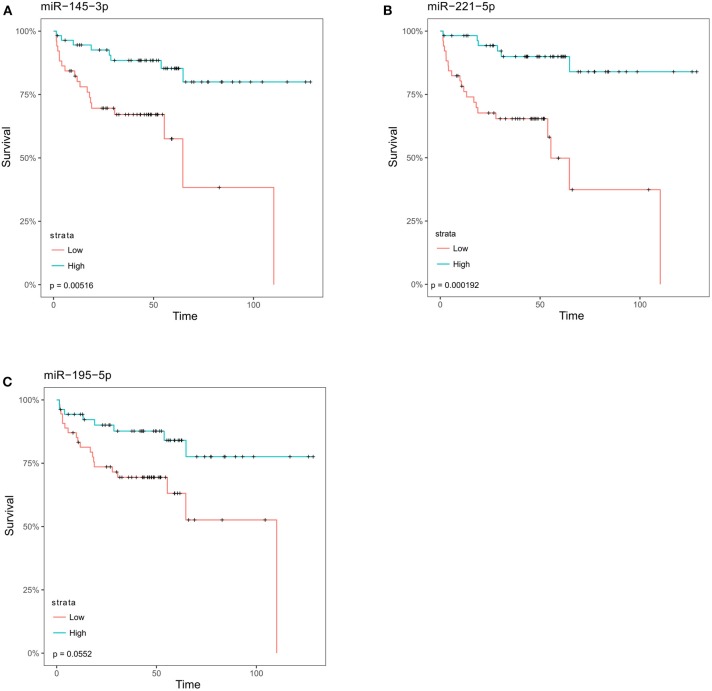
MicroRNAs identified as inhibitory in migration screen are associated with an increase in disease-free survival. Following analysis of the Taylor dataset, those microRNAs that were significantly decreased in metastatic prostate cancer as compared to primary tumor were overlapped with microRNAs found to inhibit migration (Z-score < −1). The overlapping samples were then stratified into low- and high-expressing groups relative to the median for each microRNA. Kaplan Meier survival curves for (A) miR-145-3p, (B) miR-221-5p, (C) miR-195-5p. p-values shown are corrected for multiple testing using the Bonferroni method.